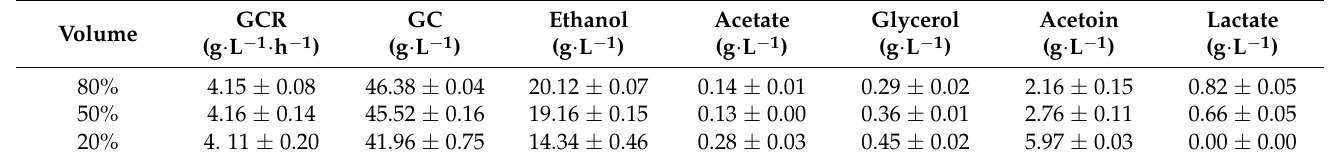
Table 4. Fermentation profiles of the recombinant strain ZM4 (pEZ-NoxE) containing NADH oxidase NoxE under different conditions. GCR: Glucose consumption rate, GC: Glucose consumed. Strains